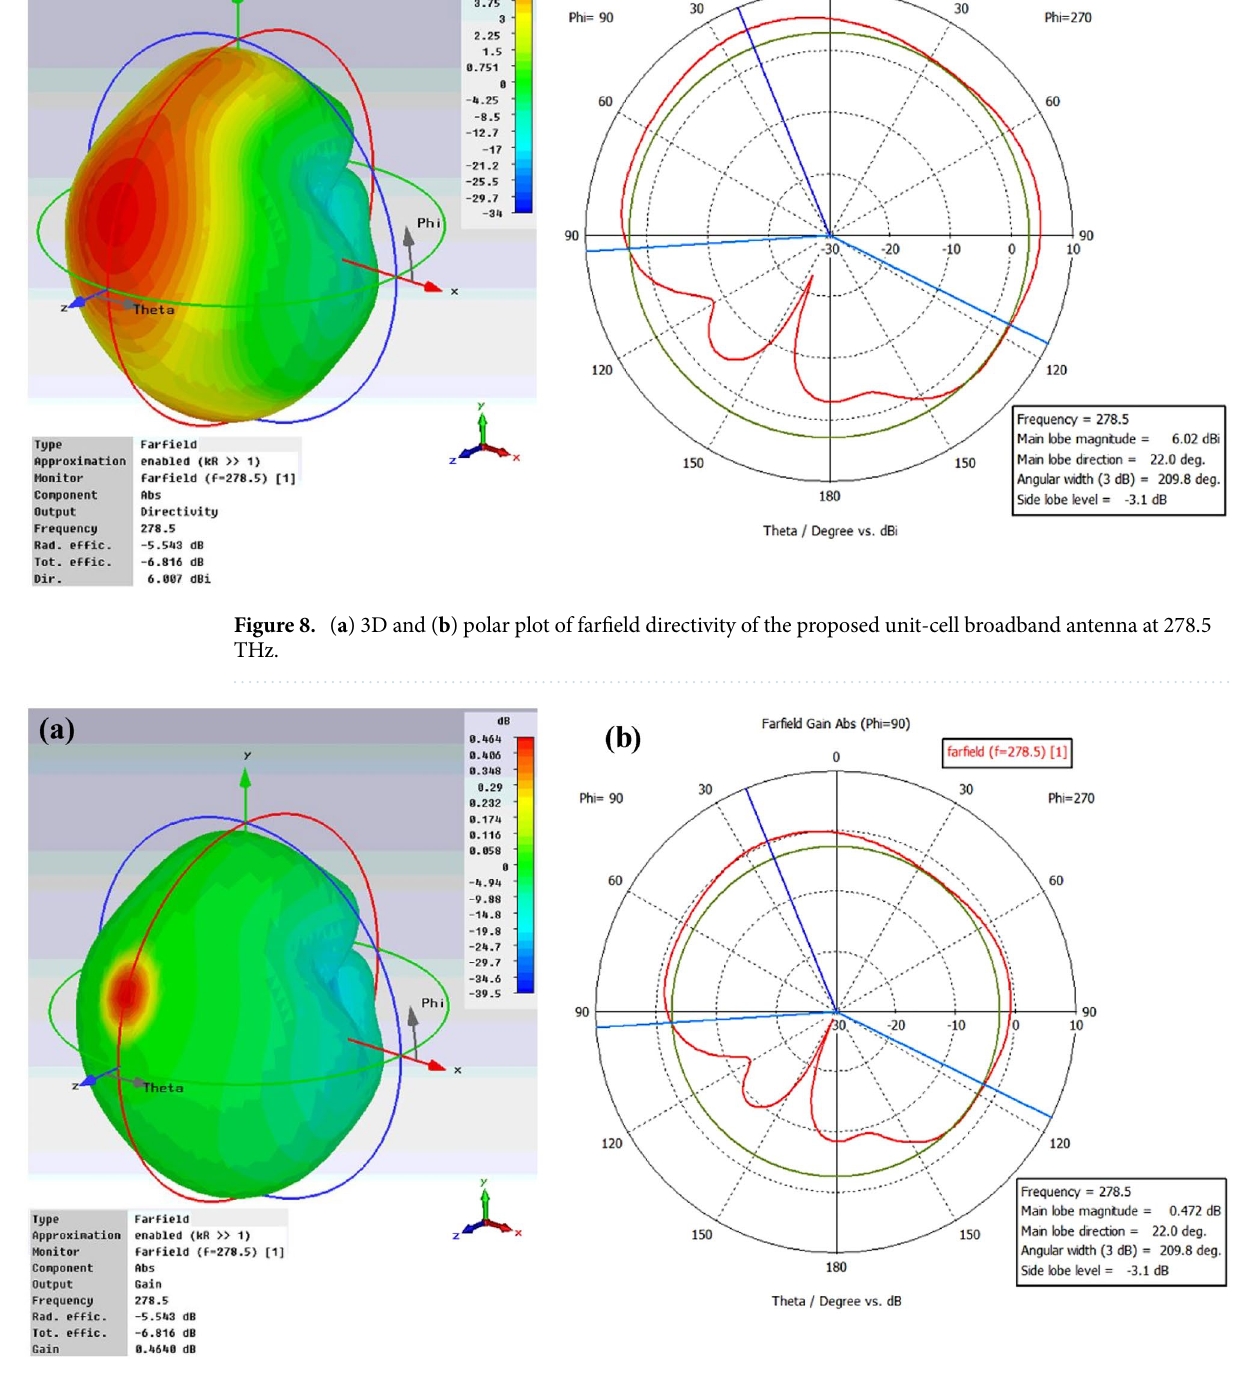
Figure 9. ( a ) 3D and ( b ) polar plot of gain of the proposed unit-cell broadband antenna at 278.5 of the top metal, and overlapping of the consecutive resonance frequencies. The absorption performance remains nearly unchanged under oblique incidence of plane wave up to 45° for both TE and TM mode polarization. The antenna is also polarization insensitive up to 90° for both TE and TM modes under normal incidence of the plane wave. The proposed unit cell antenna also exhibits high directivity and gain that helps to capture EM radiation efficiently from several directions. The numerical findings indicate the technological potential of the proposed antenna design to be utilized in DC power supply modules of low power electronic devices, bolometric sens- ing, camouflaging, solar power generation, THz imaging, and spectral imaging. We may utilize this antenna to